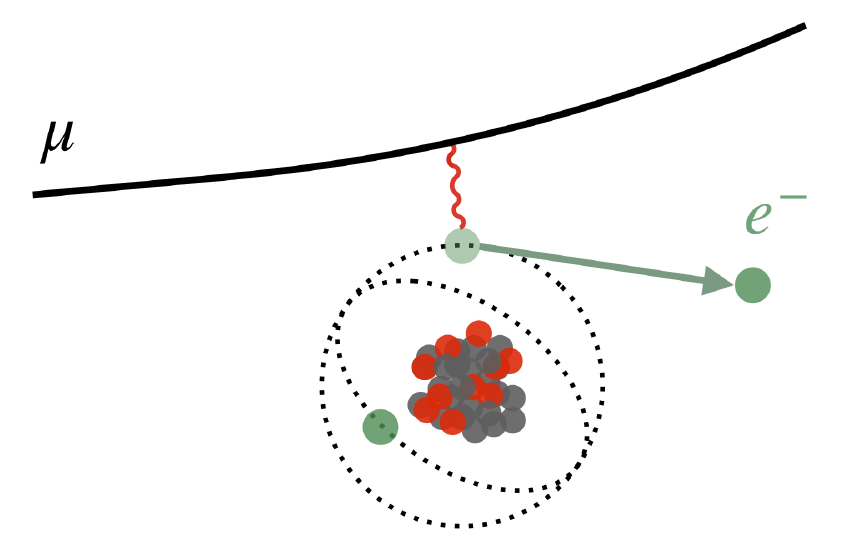
Figure 4. Muon ionisation process.